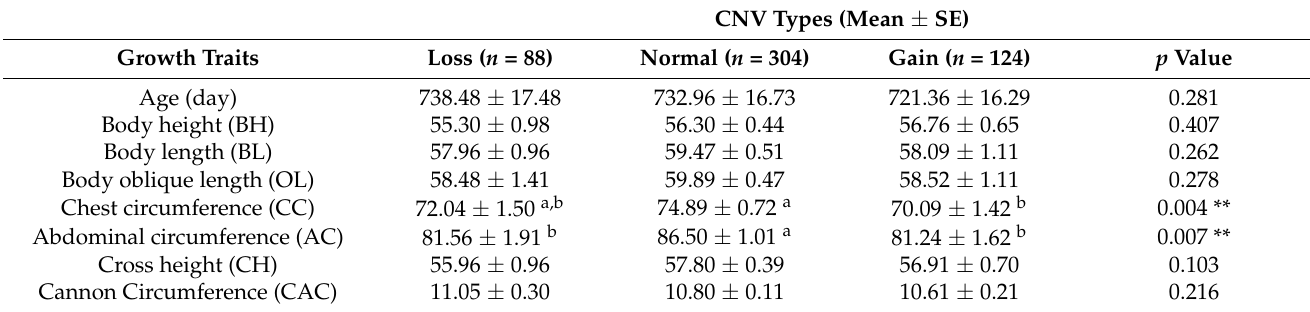
Table 1. Relationship of copy number of SNX29 CNV with growth traits in Xiangdong black goats.